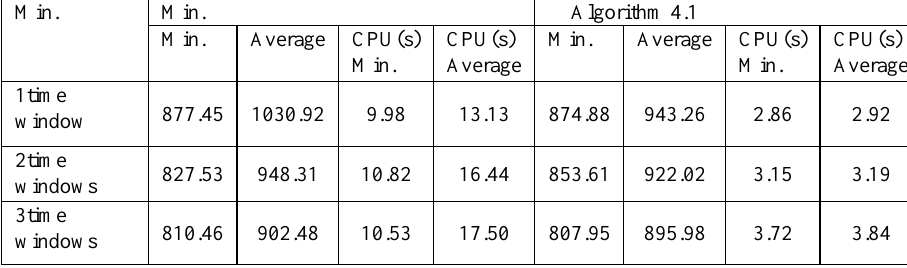
Table 2. Comparison of the results of simulated annealing algorithm and Algorithm 4.1 Min. Algorithm